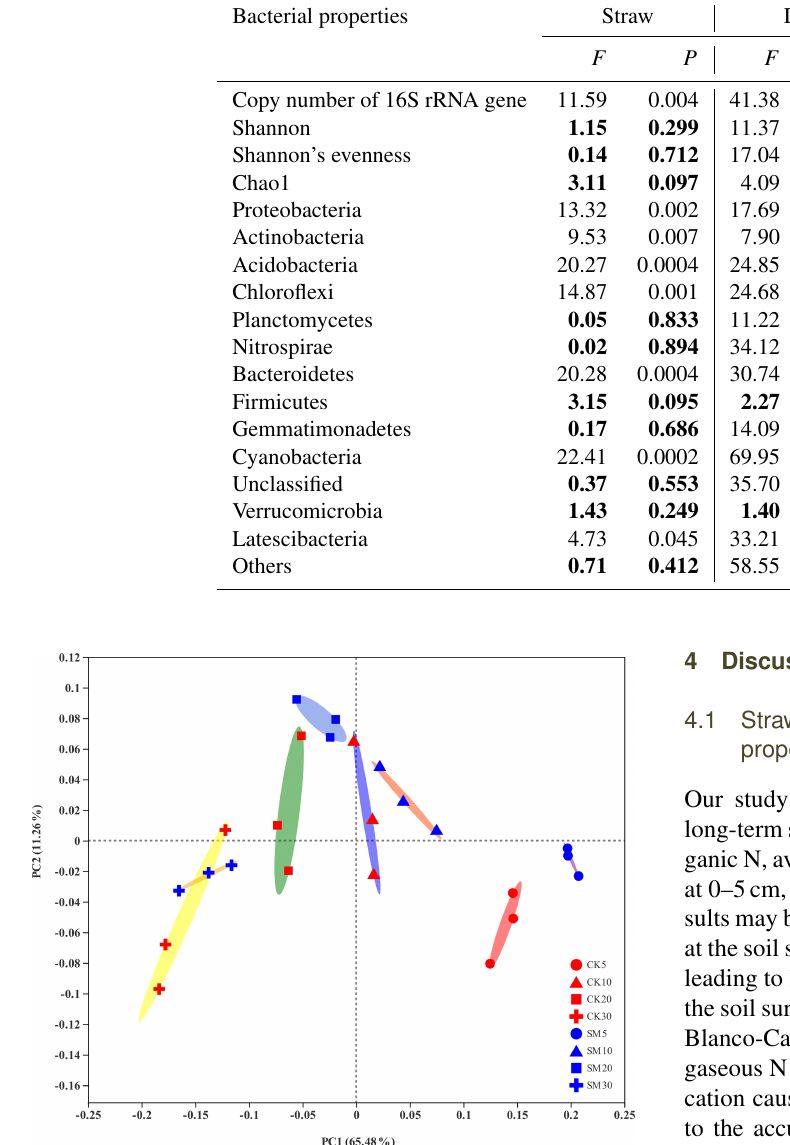
Figure 2. Principal coordinate analysis (PCoA) plot of soil bac- terial communities based on OTUs from 24 samples. CK5, CK10, CK20, and CK30 represent soils sampled at 0–5, 5–10, 10–20, and 20–30cm, respectively, from the straw removal group. SM5, SM10, SM20, and SM30 represent soil sampled at 0–5, 5–10, 10–20, and 20–30cm, respectively, from the straw mulching group. The el- lipses serve as visual aids to distinguish between different straw treatments at different soil depths and have no statistical